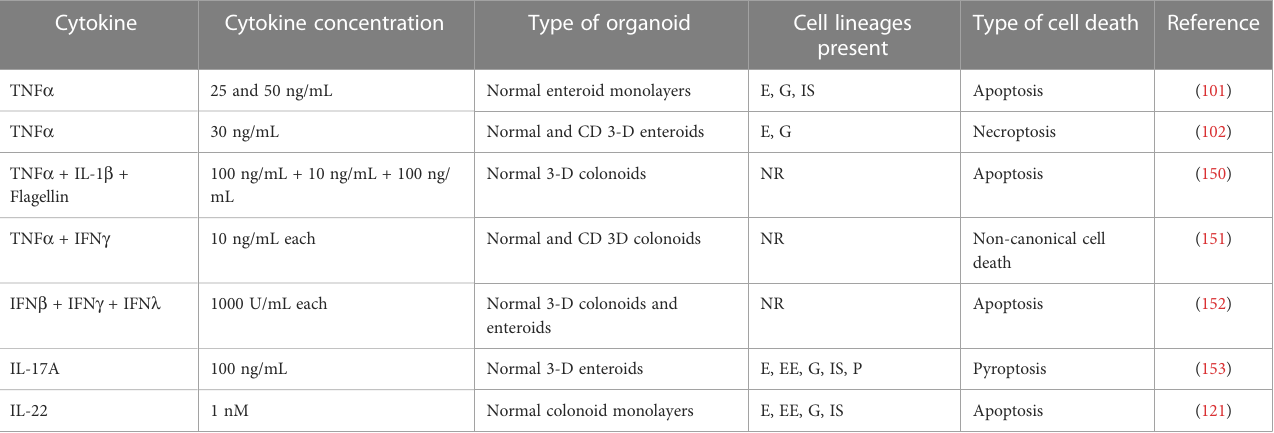
TABLE 2 In fl ammatory cytokine-induced cell death in human intestinal organoids.